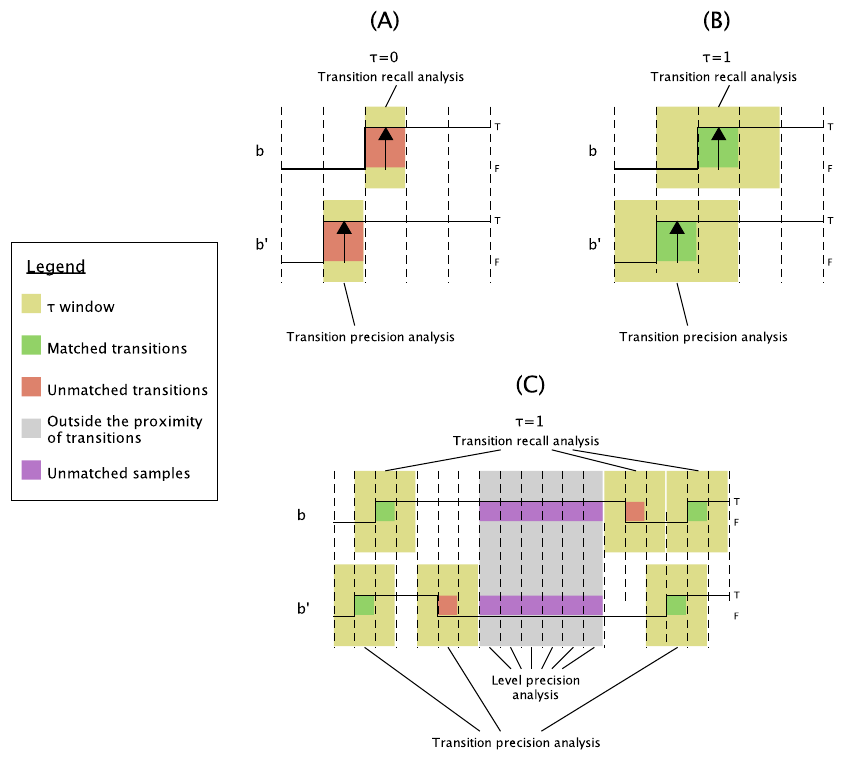
Figure 5. Illustration of the metrics analysis process. ( A ) Transition recall analysis with τ = 0. In red, unmatched transitions; ( B ) transition recall analysis with τ = 1. In green, matched transitions; ( C ) extended transition recall analysis with τ = 1. In green, matched transitions; in red, unmatched transitions; in purple, unmatched